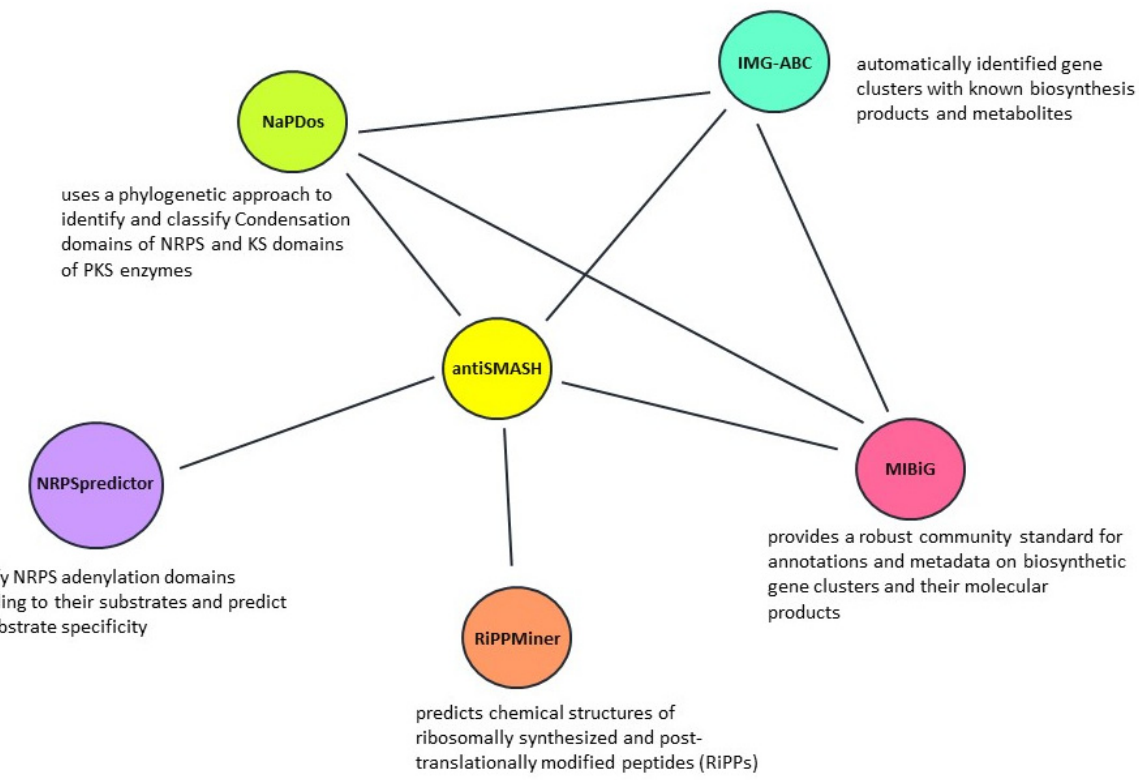
Figure 1. A conceptual framework of tools used for Streptomyces genome mining for the discovery of biosynthetic gene clusters (BGCs).